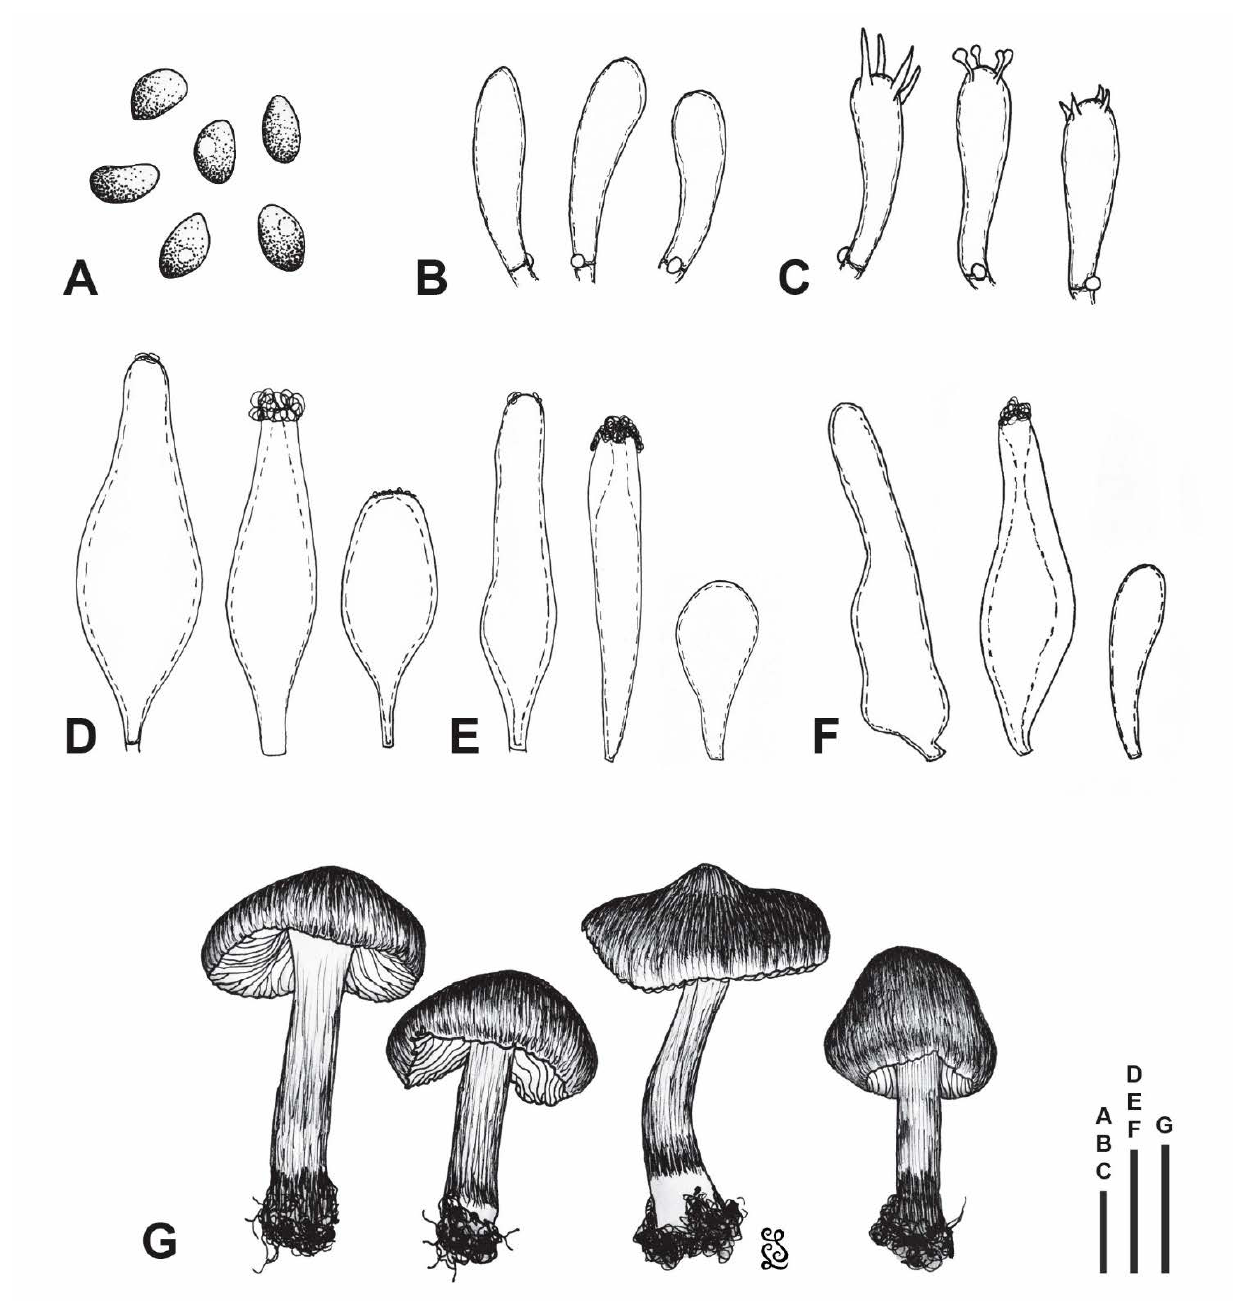
Figure 4. Inocybe brijunica (CNF 1/7345, holotype). ( A ) Basidiospores. ( B ) Basidioles. ( C ) Basidia. ( D ) Pleurocystidia. ( E ) Cheilocystidia). ( F ) Caulocystidia. ( G ) Basidiomata. Bars: ( A – C ) = 10 µ m; ( D – F ) = 20 µ m; ( G ) = 10